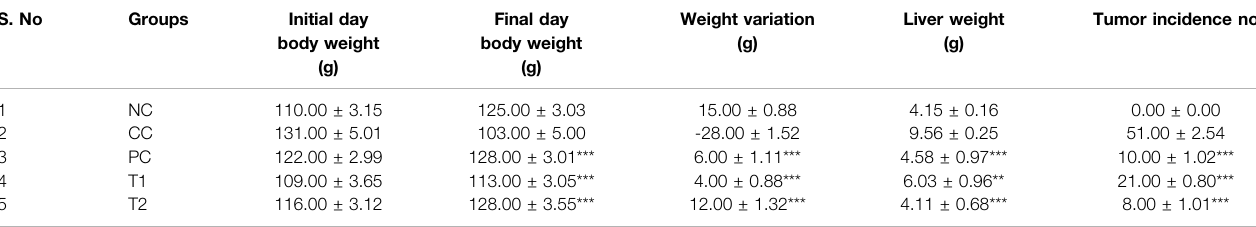
TABLE 1 | DI chemotherapy effects on liver markers in rats with DEN-induced carcinogenesis (NC, Normal Control; CC, Carcinogen Control; PC, Positive Control; T1: DI (100 mg/kg) and T2: DI (200 mg/kg). S. No